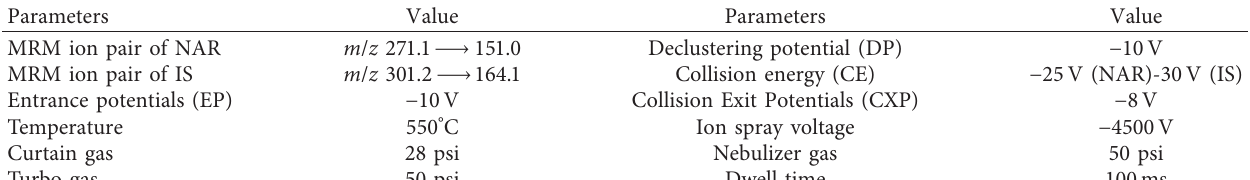
Table 1: Mass spectrometry parameters.